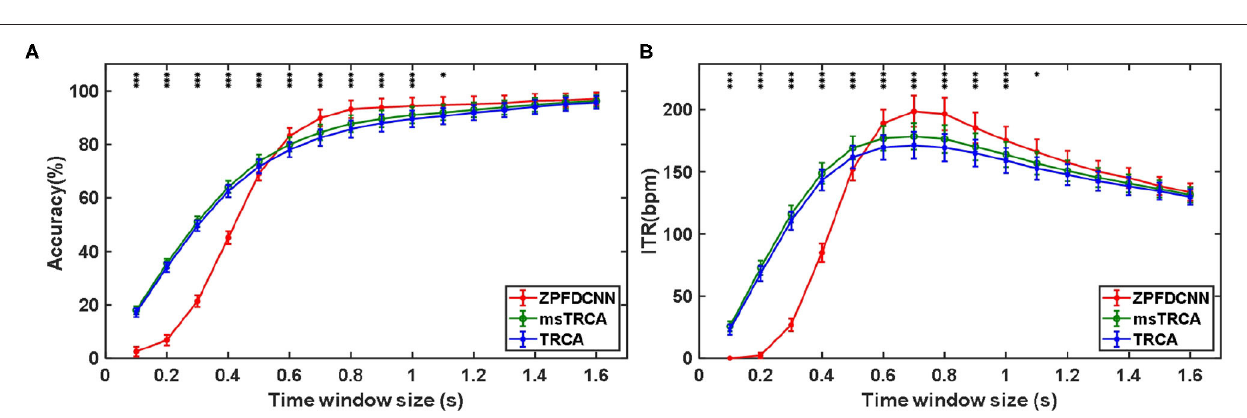
FIGURE 6 | Under the time window of 1.0 s, the confusion matrix for one of the 10-fold cross-validation of the BETA:SSVEP dataset.